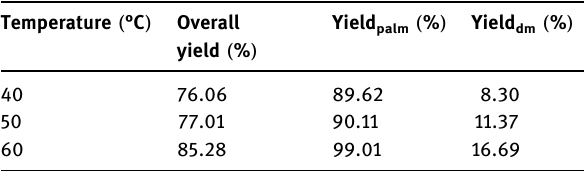
Table 6: Biodiesel yield for various temperatures Temperature ( °C )